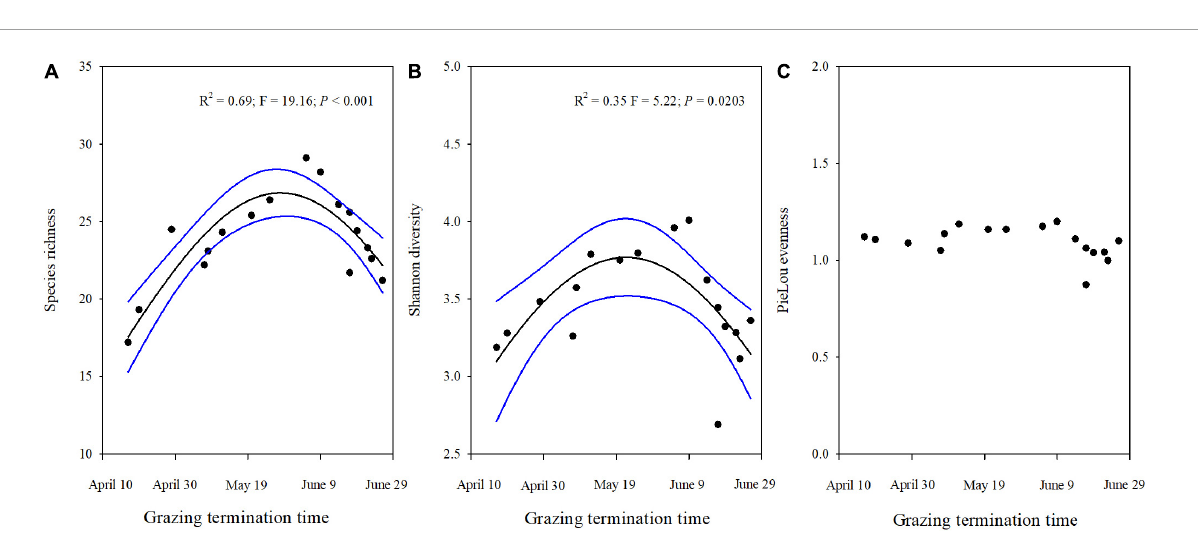
FIGURE5 Plant diversity (A) Species richness; (B) Shannon diversity, and PieLous evenness (C) for different grazing termination times on winter pastures in alpine meadows based on linear regressions. The black lines indicate significant regression relationships and blue lines indicate the smoothed regressions with its 95% confidence